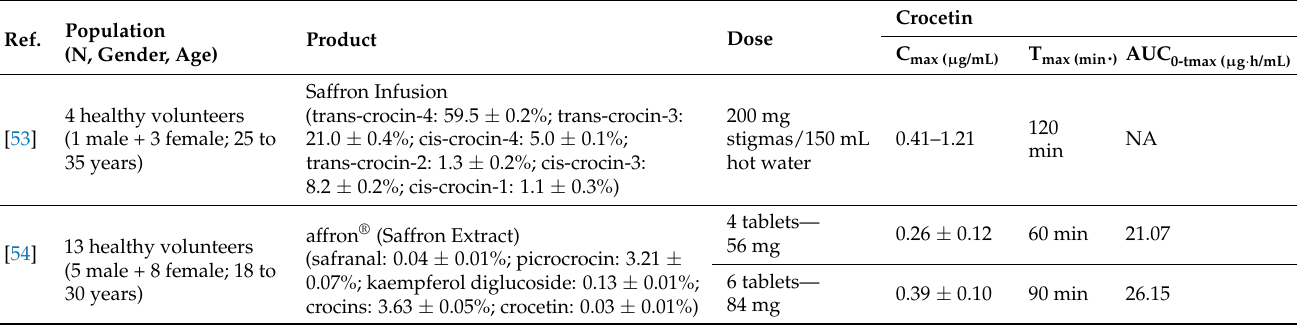
Table 3. Pharmacokinetic parameters estimated for crocetin in human